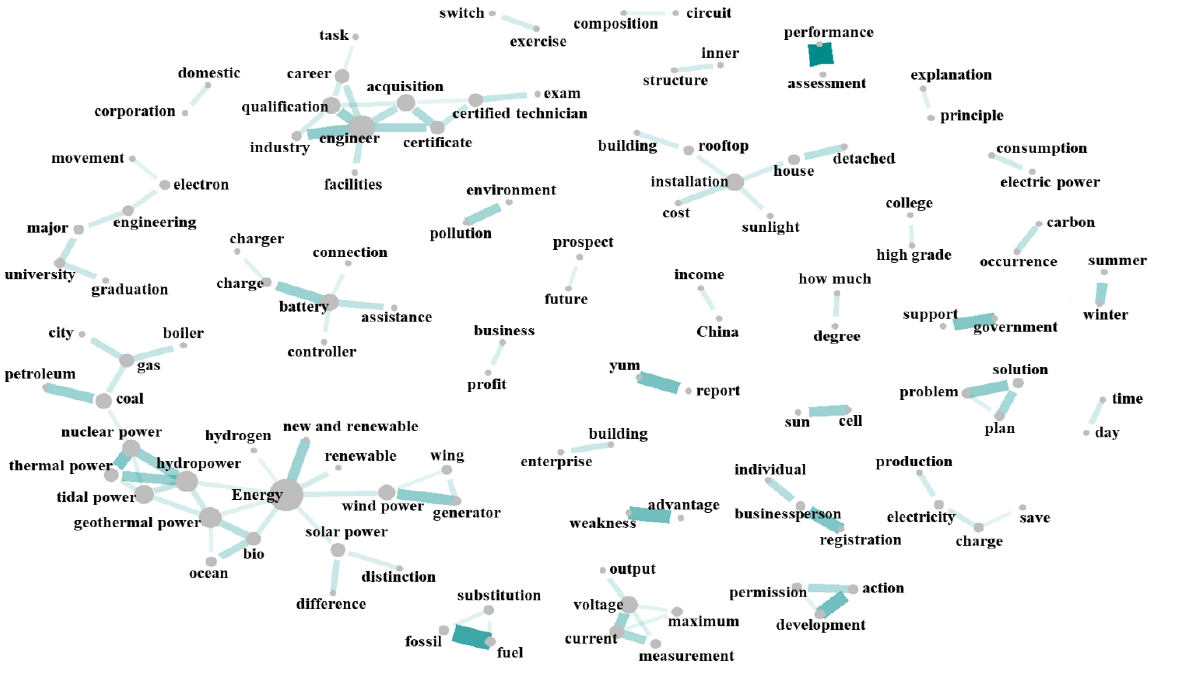
Figure 3. Word network map.